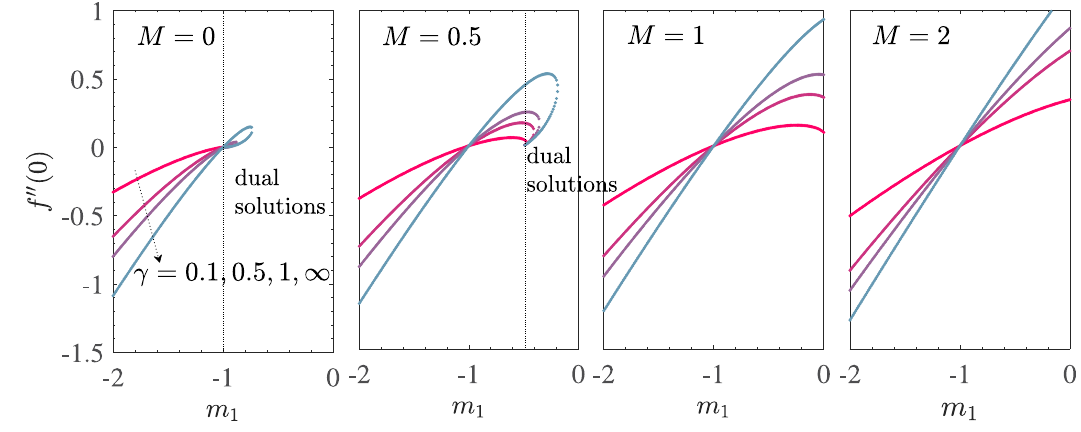
Fig 4. f 00 (0) vs m 1 for V c = 1, γ 1 = 0.1 = − γ 2 , d = − (1 + m 1 ) for the shrinking sheet case with mass